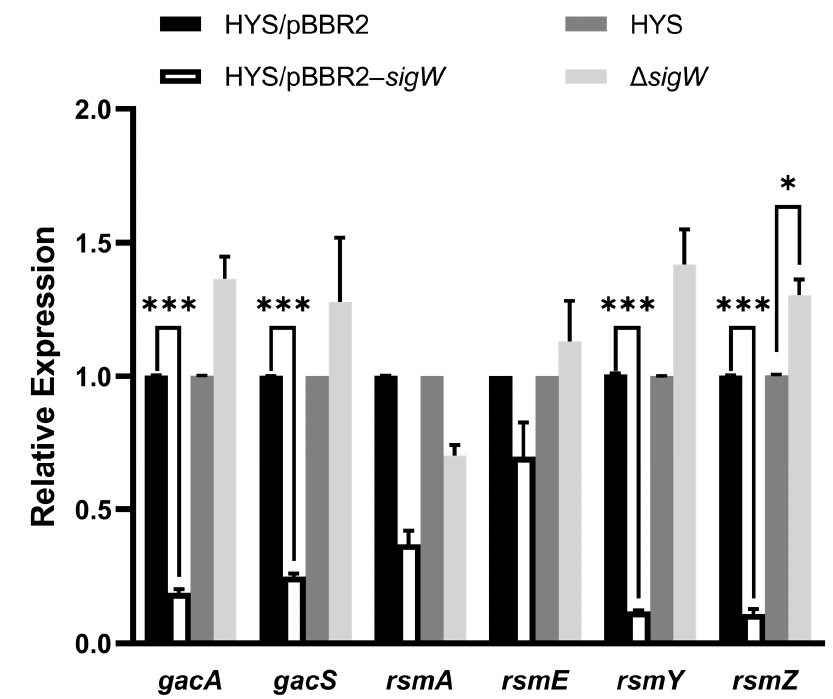
Figure 8. The regulatory relationship between SigW and the Gac/Rsm cascade system. Expression of gacA/S , rsmA/E , and rsmY/Z in P. donghuensis HYS. RNA was isolated from the indicated strains grown to the exponential phase at 30 °C in liquid MKB culture. Error bars indicate the mean ± SD of three independent experiments. Statistical significance was calculated using one-way ANOVA Dunnett’s multiple comparison test, * p < 0.01; ** p < 0.001; *** p < 0.0001.